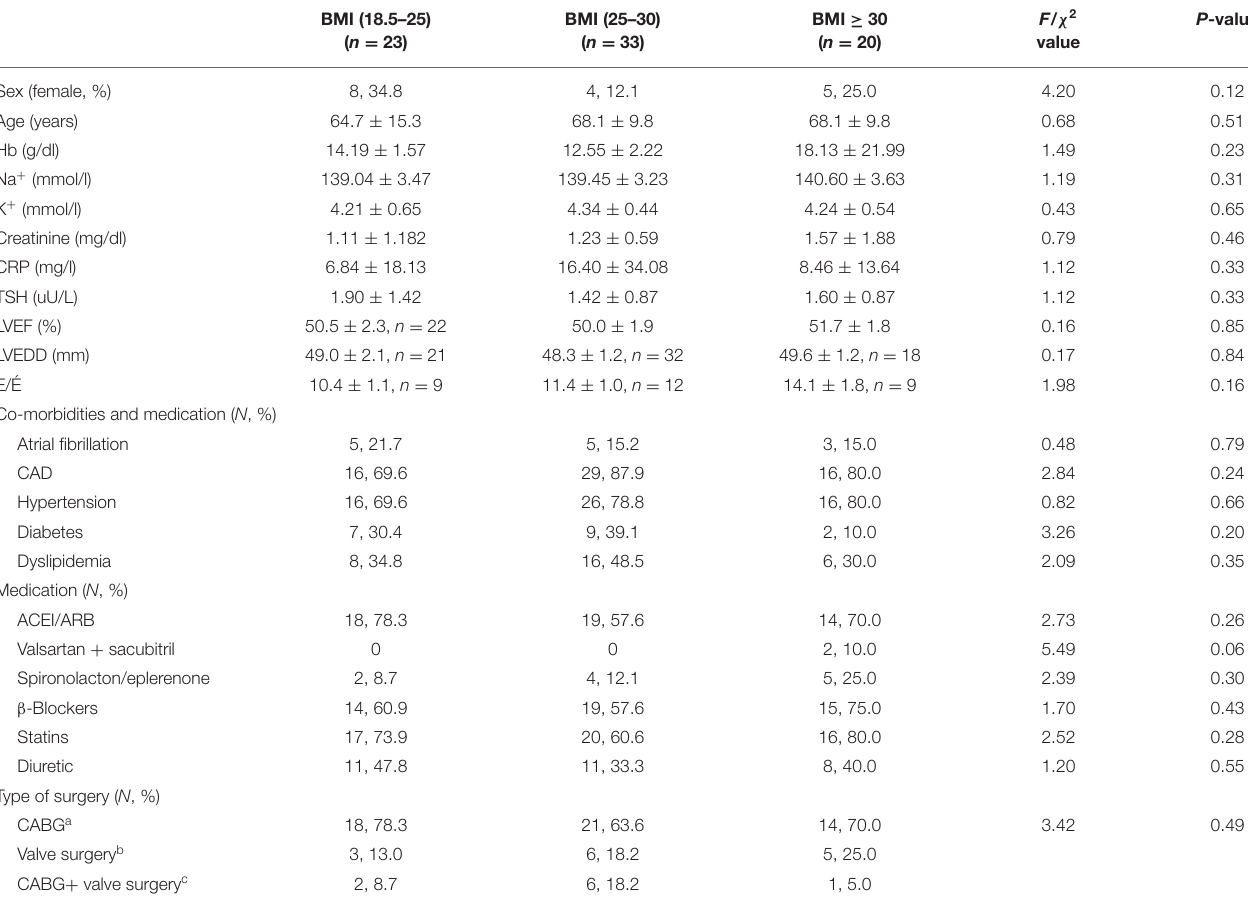
TABLE 1 | Clinical